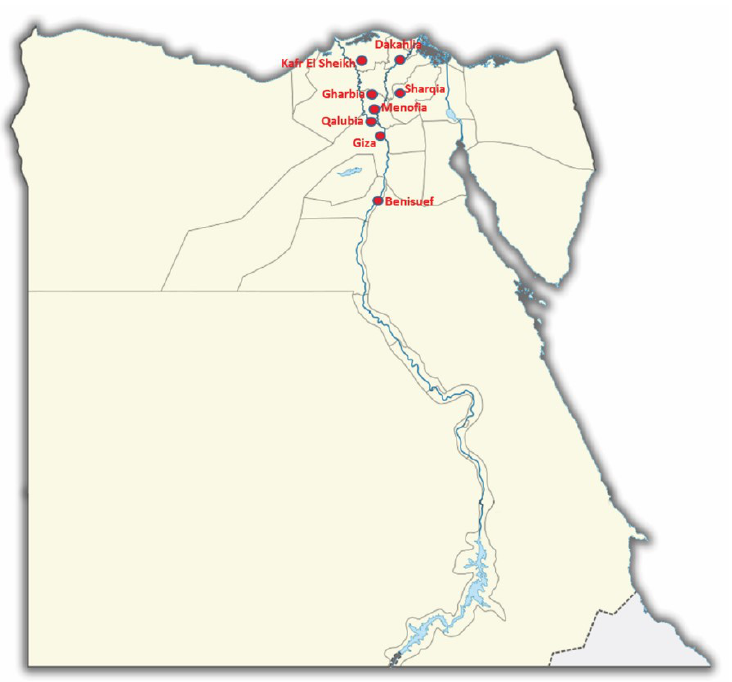
Figure 1. Map of Egypt showing regions (Governorates) of where samples were collected from wild birds. Table 1. Overview of wild bird samples involved in the study, and the prevalence of Avian coronaviruses (ACoVs) in different species.